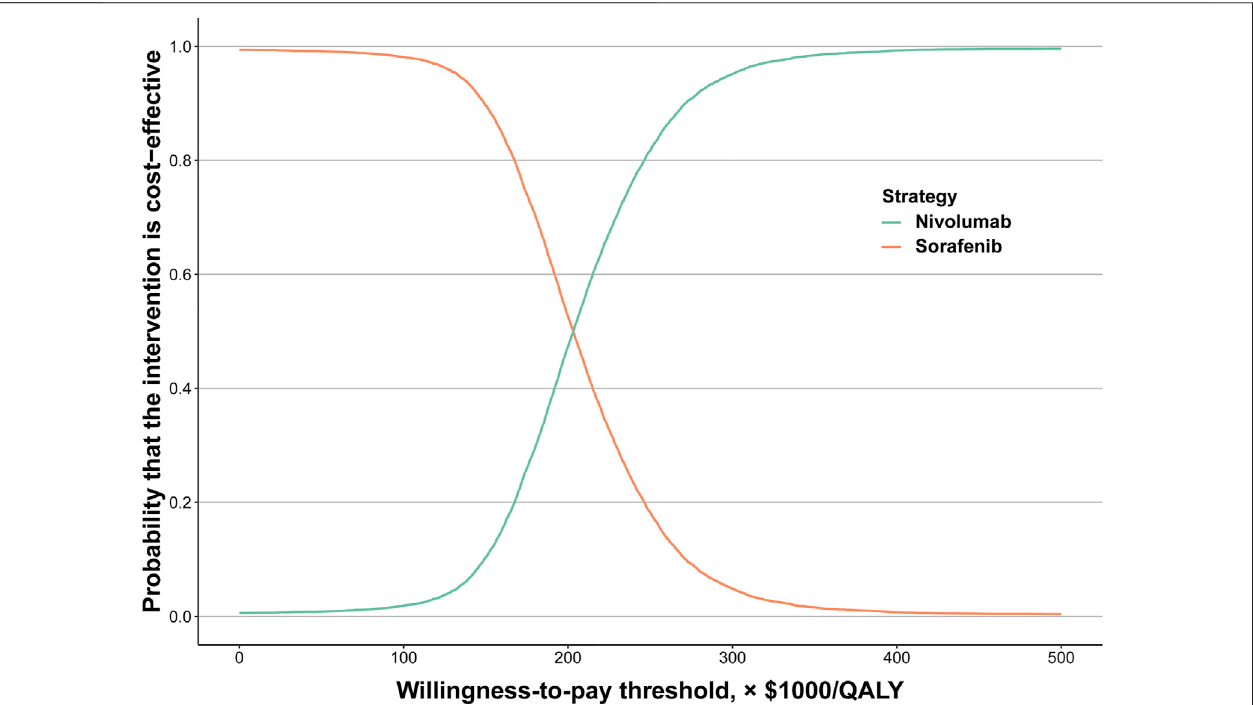
FIGURE 2 | Acceptability curves of cost-effectiveness for nivolumab versus sorafenib. Abbreviations: QALY, quality-adjusted life-year